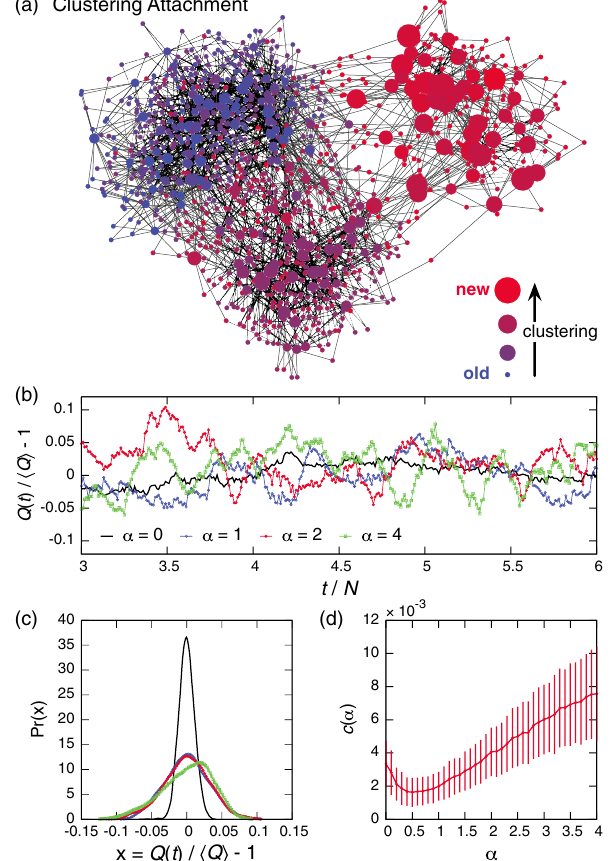
FIG. 1. Network growth according to clustering. (a) A realiza- tion of clustering attachment ( (cid:1) ¼ 2 ). Node size is proportional to clustering, and node color represents the age of the node (time since it was injected). Communities emerge approximately se- quentially in time. (b) A measurement of the model’s community structure using modularity Q by running a community detection algorithm [26] while a network evolves according to CA. Raw modularity scores may be problematic since sparsity alone can potentially force Q to high values [28,29]. We instead consider Q relative to h Q i , the average value observed over the course of the model. We see fluctuations in modularity over time for (cid:1) (cid:1) 0 far larger than observed for purely random attachment ( (cid:1) ¼ 0 ). This quantifies the successive emergence and dissolution of modular structure in the model. These fluctuations occur for both growing and stationary networks. (c) The relative distributions of Q during the temporal evolution shown in (b). The random case is sharply peaked about its average value. (d) The clustering coefficient averaged over all nodes, which increases significantly as (cid:1) increases. Clustering is another hallmark of community structure. Error bars denote (cid:3) 1 s : d